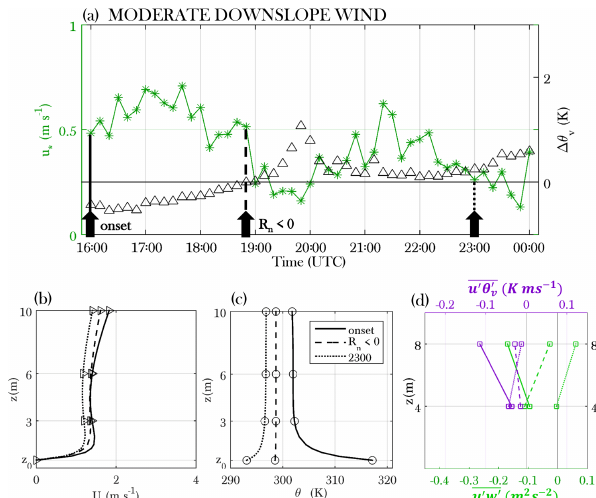
Figure 9. (a) Idem from Fig. 8 for the moderate downslope event (25 July 2017), except the change of the last time of interest from 22:30 to